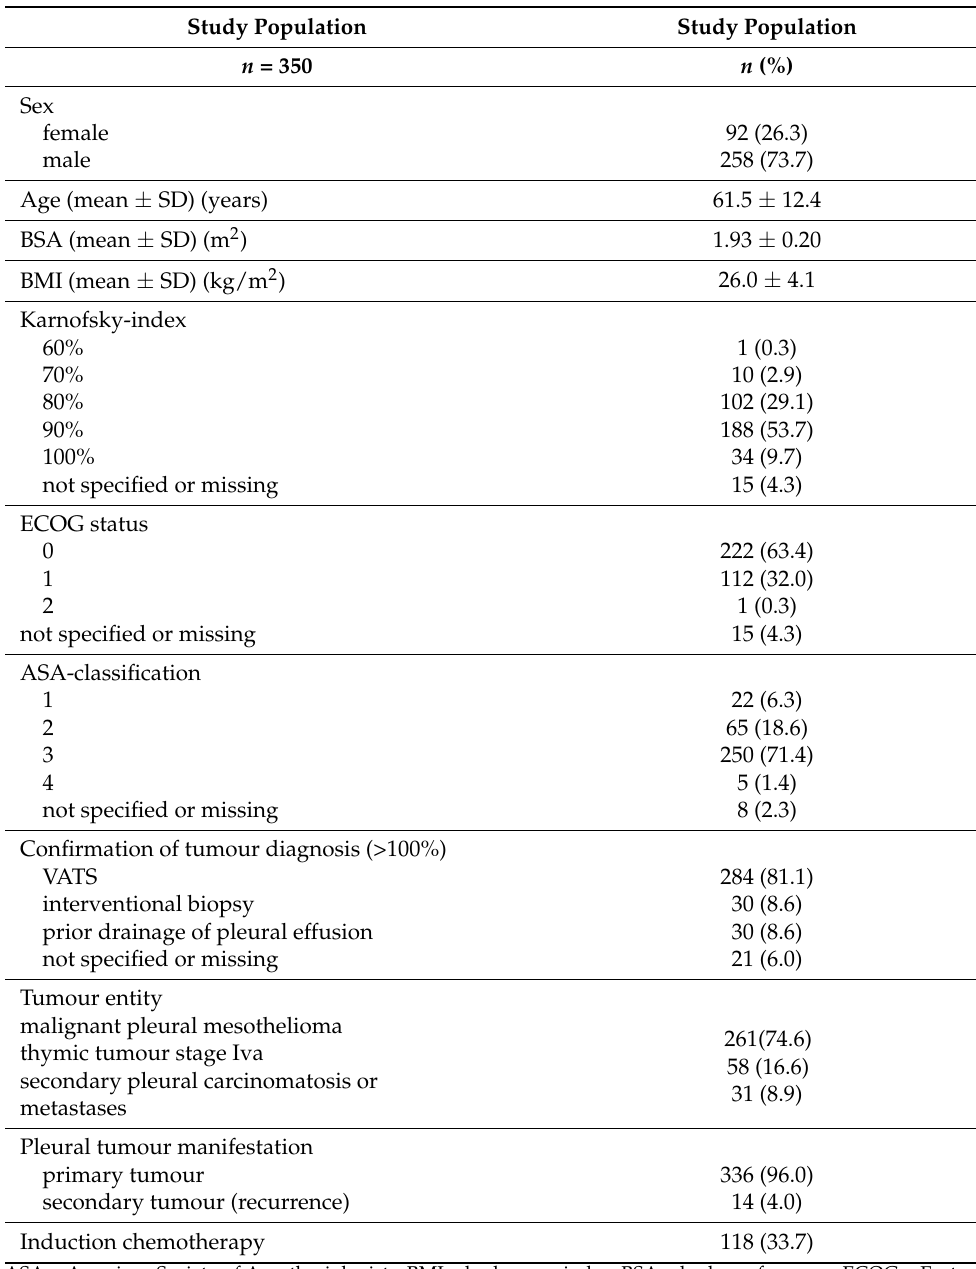
Table 1. Patient and pleural tumour